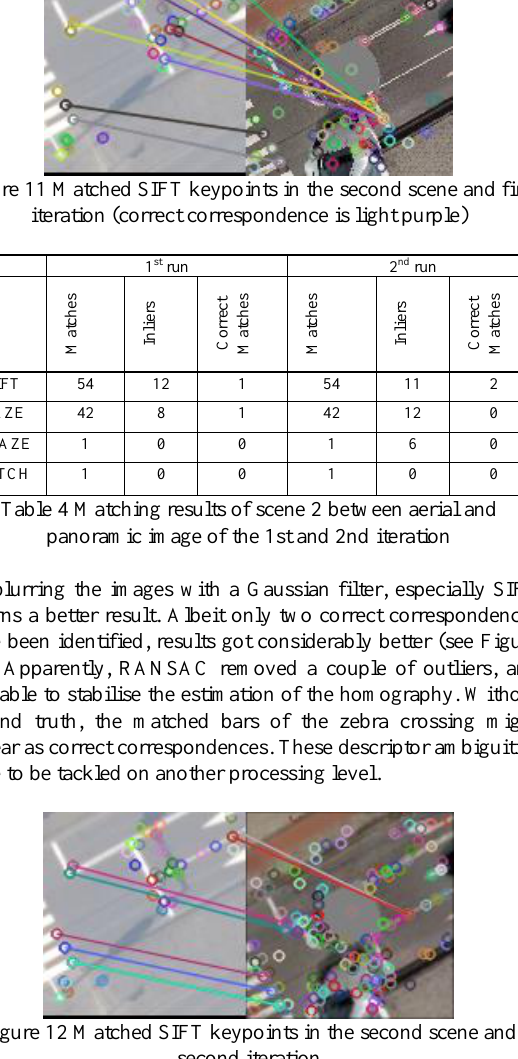
any improvement.